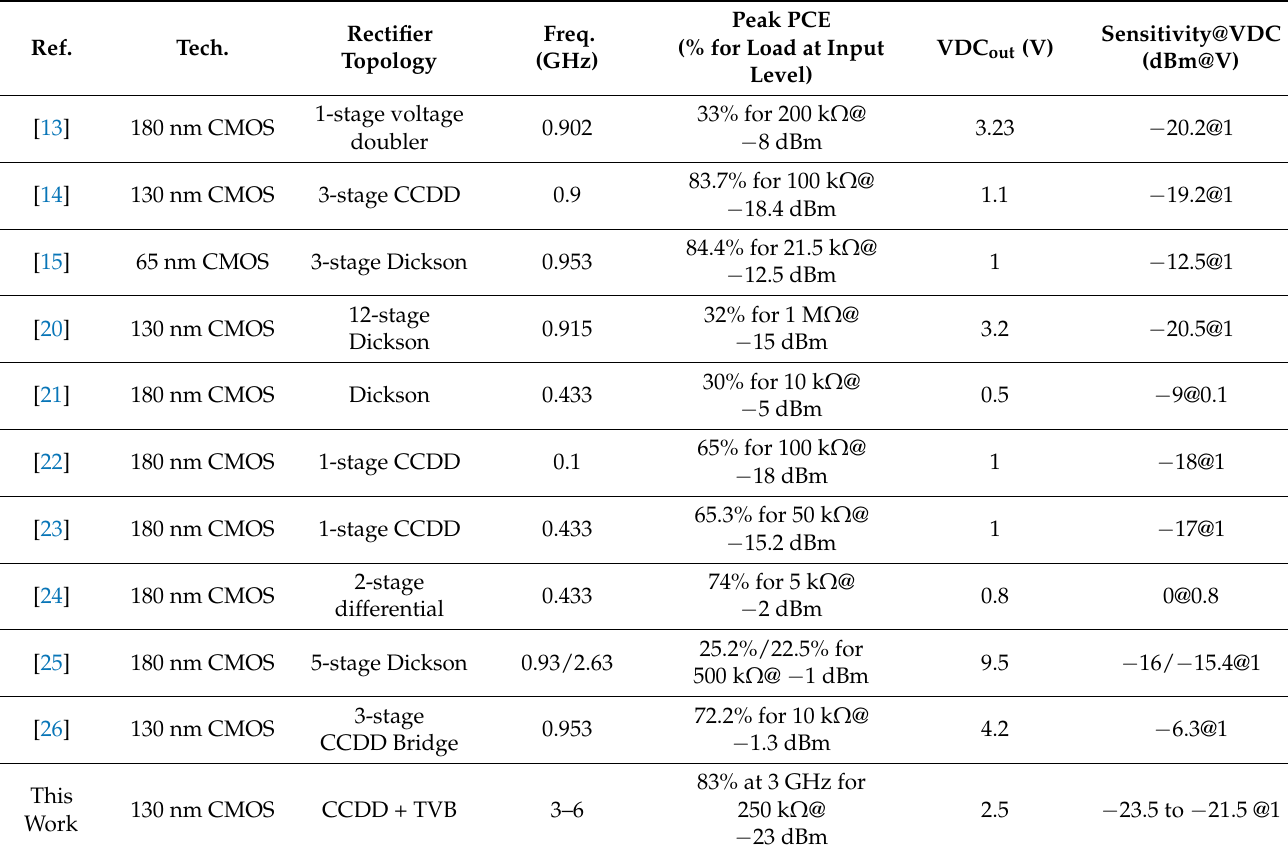
Figure 22. PCE of the CCDD-TVB rectifier across wideband frequency. Table 1. Comparison of CCDD-TVB rectifier with recent works.